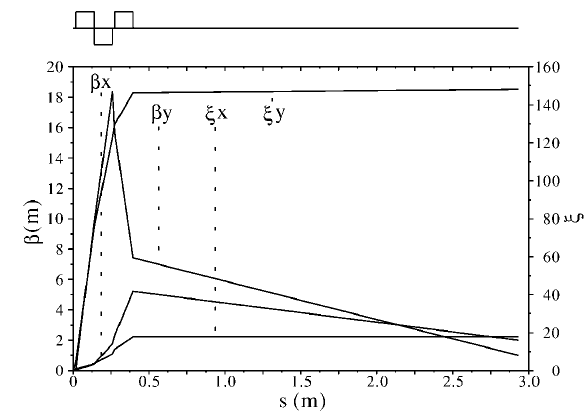
FIG. 9. The defocusing optics without chromaticity correction for laser-Compton cooling.